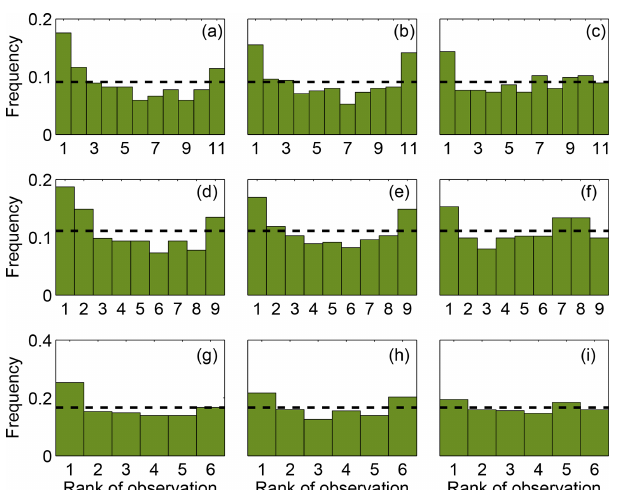
Figure 9. Rank histograms of wind speed (a, d, g) , wind direc- tion (b, e, h) and PBLH (c, f, i) using the calibrated ensembles found with SA. The upper, middle and upper lower panels correspond to the ensembles with 10, 8 and 5 members, respectively. The hori- zontal dashed line (r) corresponds to the ideal value for a flat rank histogram with respect to the number of